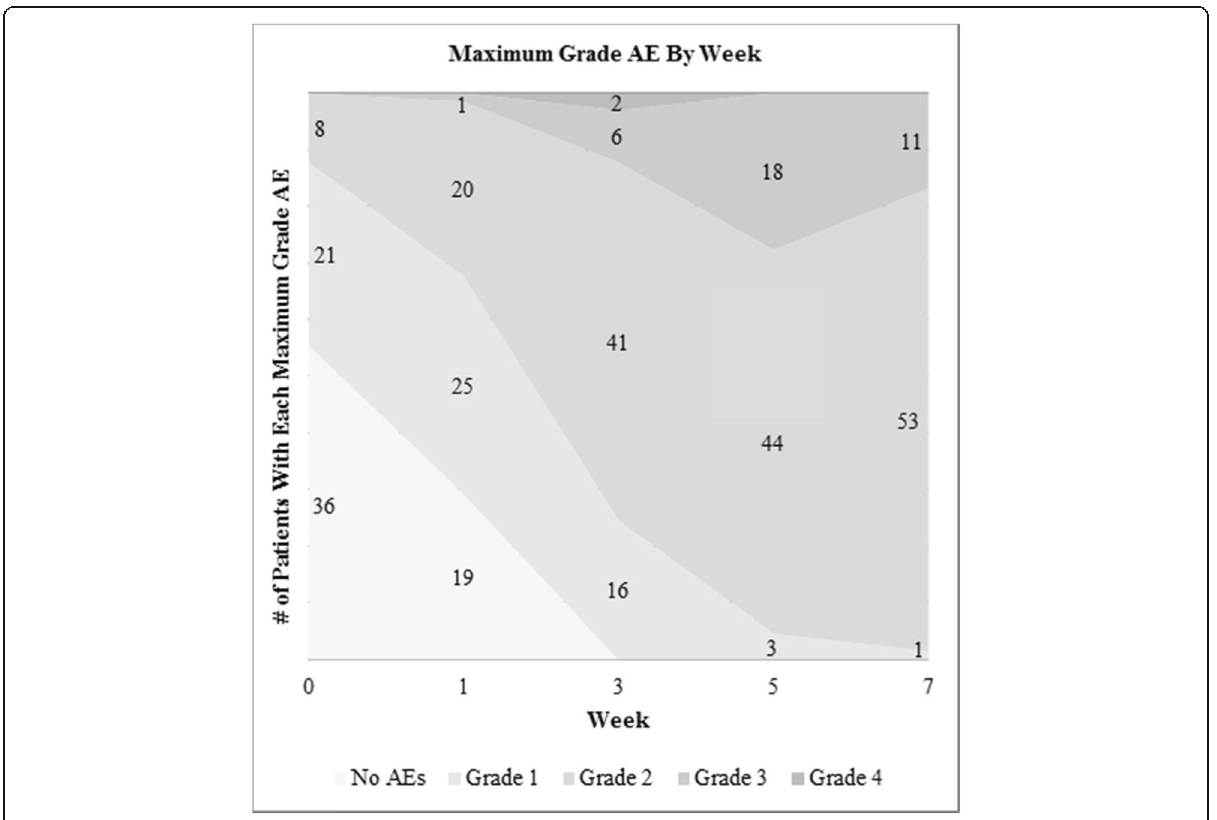
Fig. 2 Distribution of maximum grade AE by week. For reference, maximum grade AE distribution at week 3 was grade 1: 16 patients; grade 2: 41 patients; grade 3: 6 patients; grade 4: 2